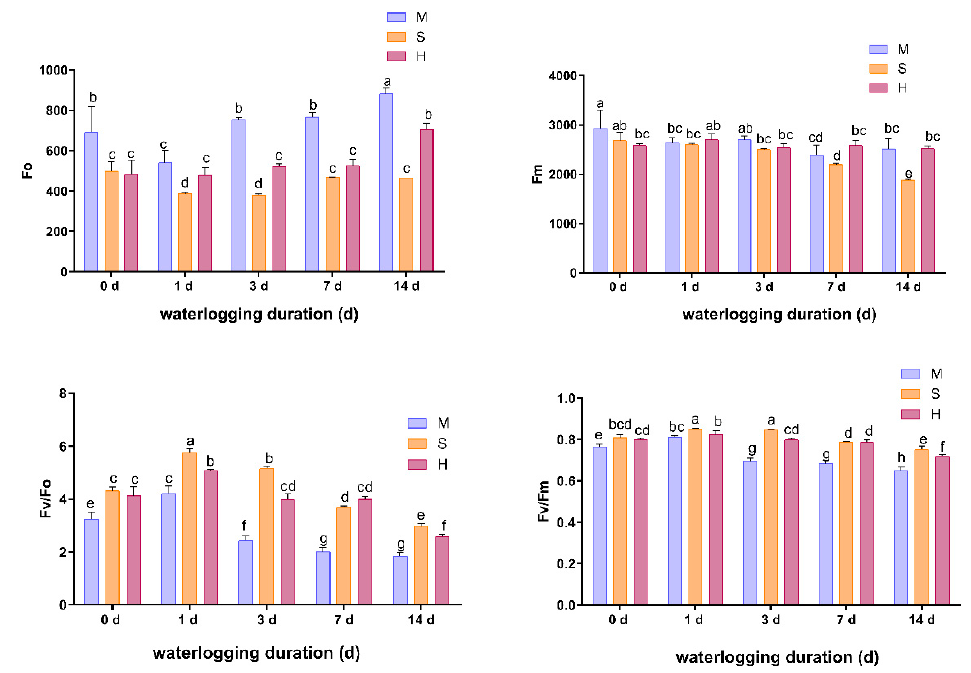
Figure 4. The chlorophyll indexes of different peach rootstocks under waterlogging stress. Abbrevi- ations: M: Prunus persica, ‘Maotao’; S: Prunus davidiana, ‘Shantao’; H: ‘Hossu’. The data are the means ± SDs. Within columns, means with a different letter indicate significant differences ( p < 0.05) using Duncan’s test; bars on the columns represent the standard errors (SD) (n = 6). The principles of light energy absorption, transformation, and utilization in different peach rootstocks seedlings under waterlogging stress were shown in Figure 5. The value of ABS/RC in M and S initially decreased momentarily (WT 0–1 d and WT 1–3 d, respec- tively), recovered, and remained at a relatively high level during the later stage of WT (WT 7–14 d), whereas that of H significantly increased at first (WT-1 d) and then sustained at a high level throughout the 14 d of WT. The total increment of ABS/RC of M, S, and H was 21.3%, 38.2%, and 39.5%, respectively. The values of TRo/RC and ABS/RC performed a similar changing pattern, whereas the value of ETo/RC varied: the ETo/RC of S de- creased constantly and that of M increased initially before decreasing dramatically until the end. In contrast, the ETo/RC value of H was maintained at a relatively consistent and high level throughout the overall 14 d of WT, which might indicate that H maintained better light energy usage efficiency than that of M and S under the same level of water- logging stress.